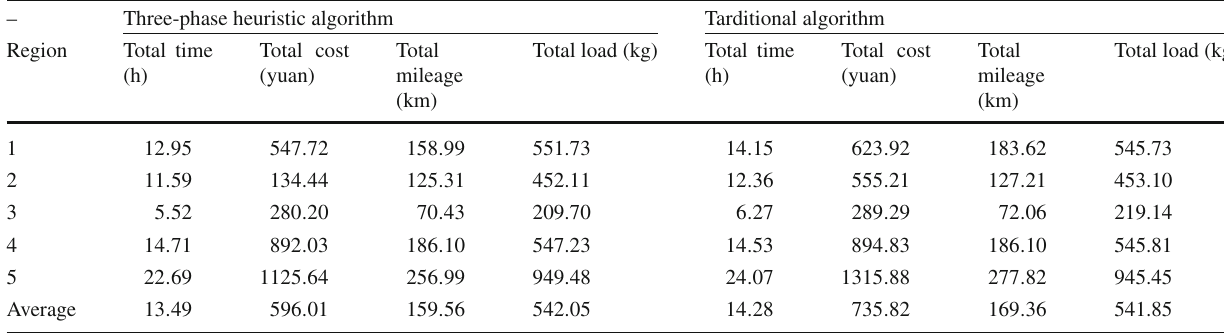
Table 6 Comparion with traditional algorithm – Three-phase heuristic algorithm Tarditional